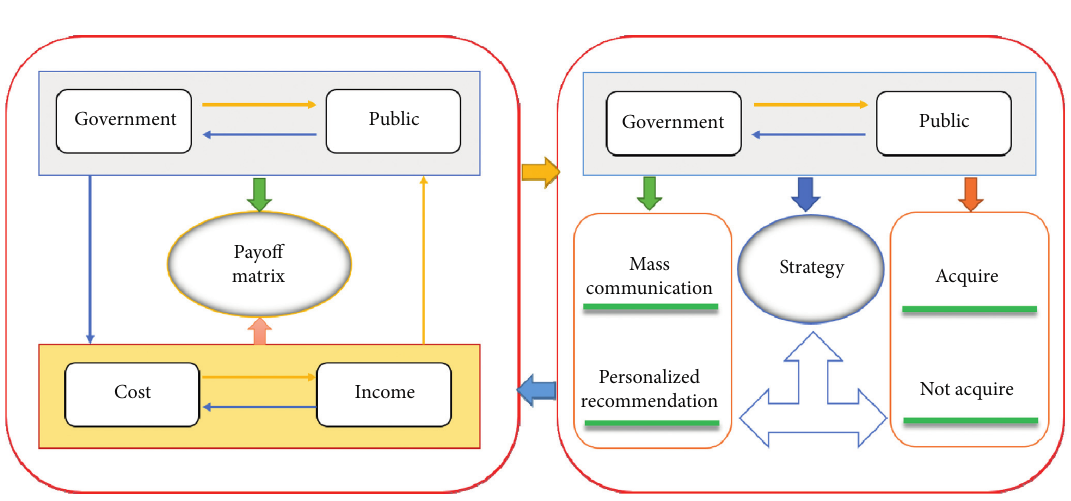
Figure 1: The logical framework of this paper. Table 4: The payoff matrix of the